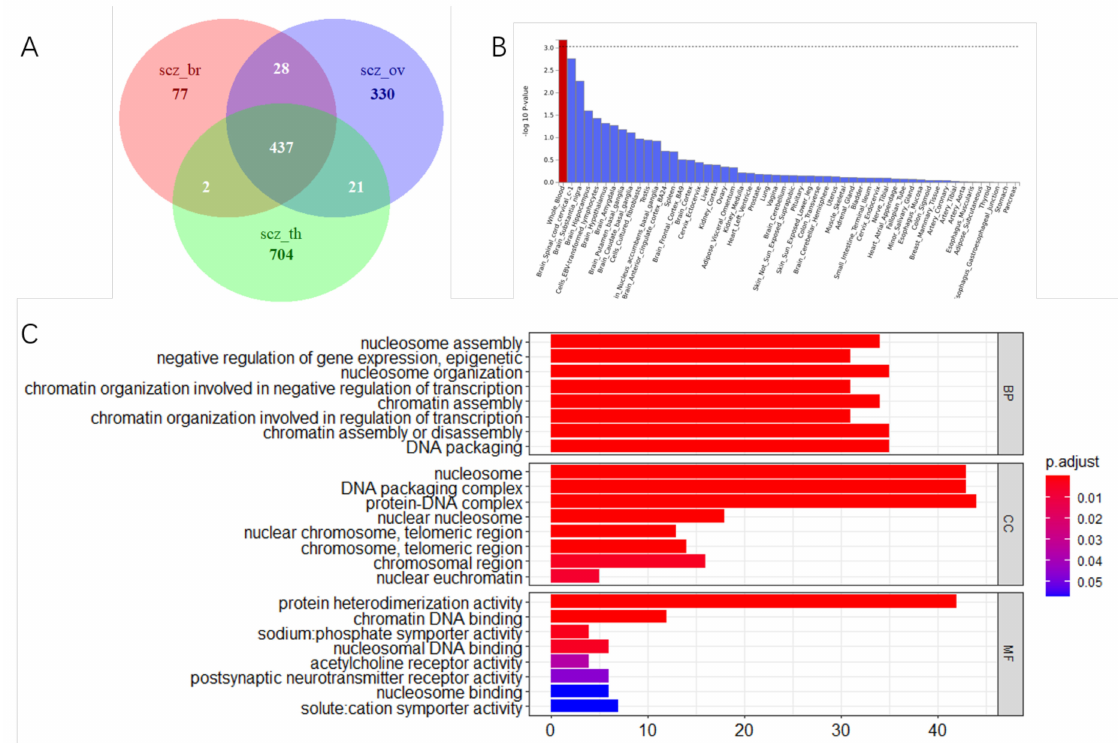
Figure 4. Functional enrichment of shared genes ( A ) Number of specific and shared genes of three study cohorts; ( B ) tissue expression enrichment in GTEx tissue types. The dashed line indicates the significance threshold at p < 0.001; ( C ) Bar-dot plots show significantly enriched gene sets annotation genes. scz_br: the common genes in schizophrenia and breast cancer; scz_ov: the common genes in schizophrenia and ovarian cancer; scz_th: the common genes in schizophrenia and thyroid